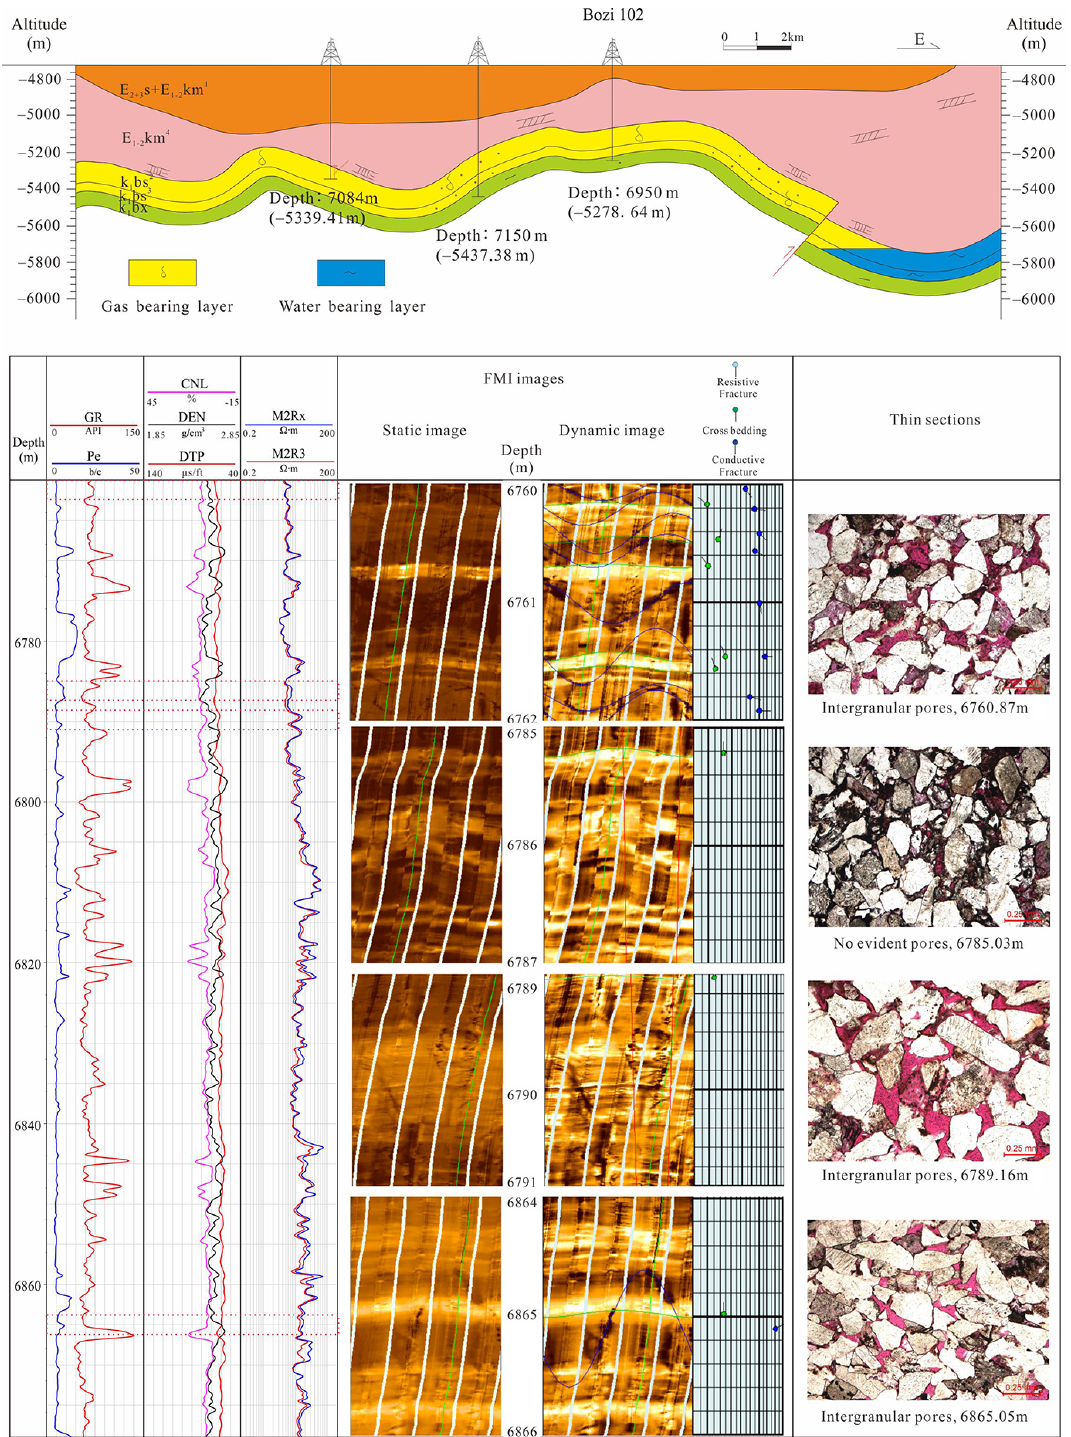
Figure 21. Cross section of Bozi 1-Bozi 101-Bozi 102 and pore spaces as well as fractures determined from thin section and image logs for Well Bozi 102. Note the dissolution pores associated with fractures, and no evident dissolution pores in layers without fractures. Well Bozi 102: 6760–6879m depth intervals, 4mm choke width, 38.41MPa drawdown pressure. The daily natural gas production is 106557m 3 .